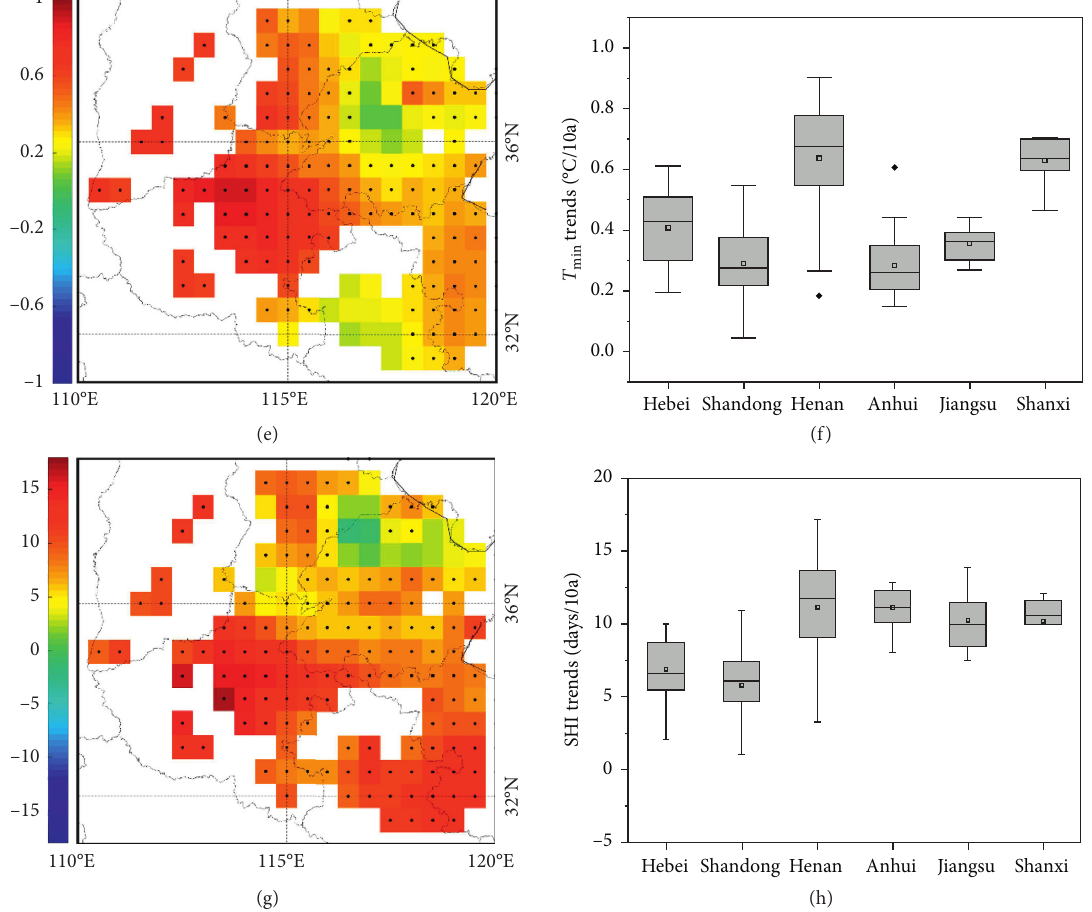
Figure 3: Spatial maps of the trends in the annual mean. (a) T (e) T min ( ° C/10a), (f) T min trends ( ° C/10a), and (g) SHI (days/10a) and the boxplot of spatial average values of (h) SHI trends (days/10a) for each province. The location of each province is shown in (a), and panels (c), (e), and (g) are the same as panel (a). The black dots in the figures indicate trends that are statistically significant ( P < 0 . 05 )